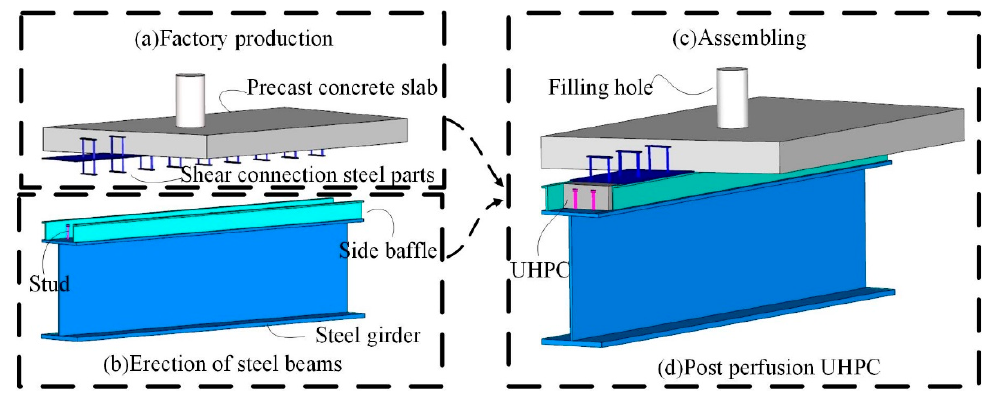
Figure 2. Design of PSCC connectors.